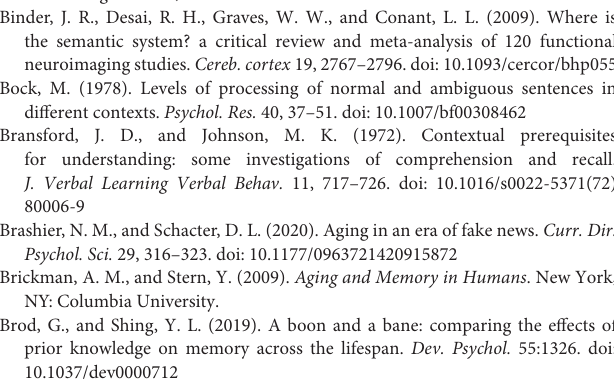
Supplementary Figure 1 | Age distribution of the sample. Supplementary Figure 2 | Higher congruency marginally related to better memory